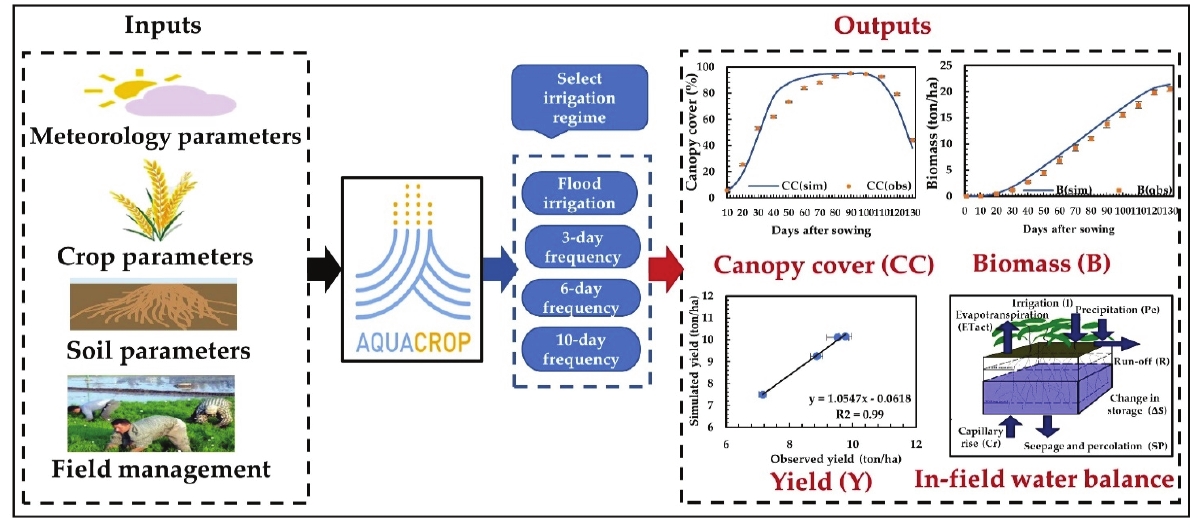
Figure 2. General methodological framework of the present study.